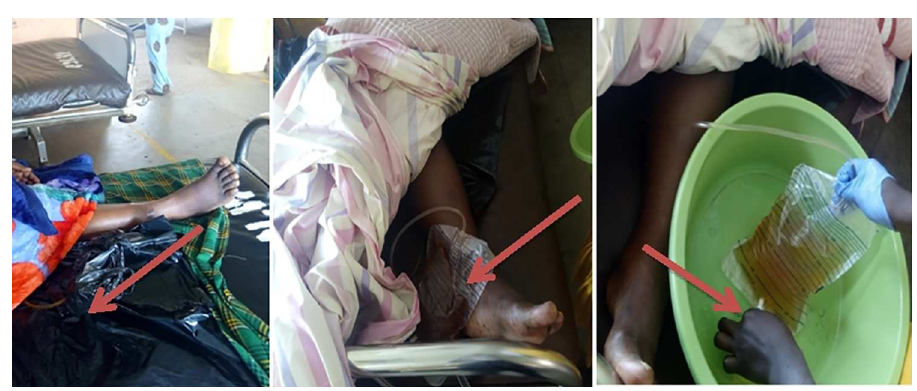
Fig 3. Showing some observed practices reported by the care-takers and demonstration of drainage bag